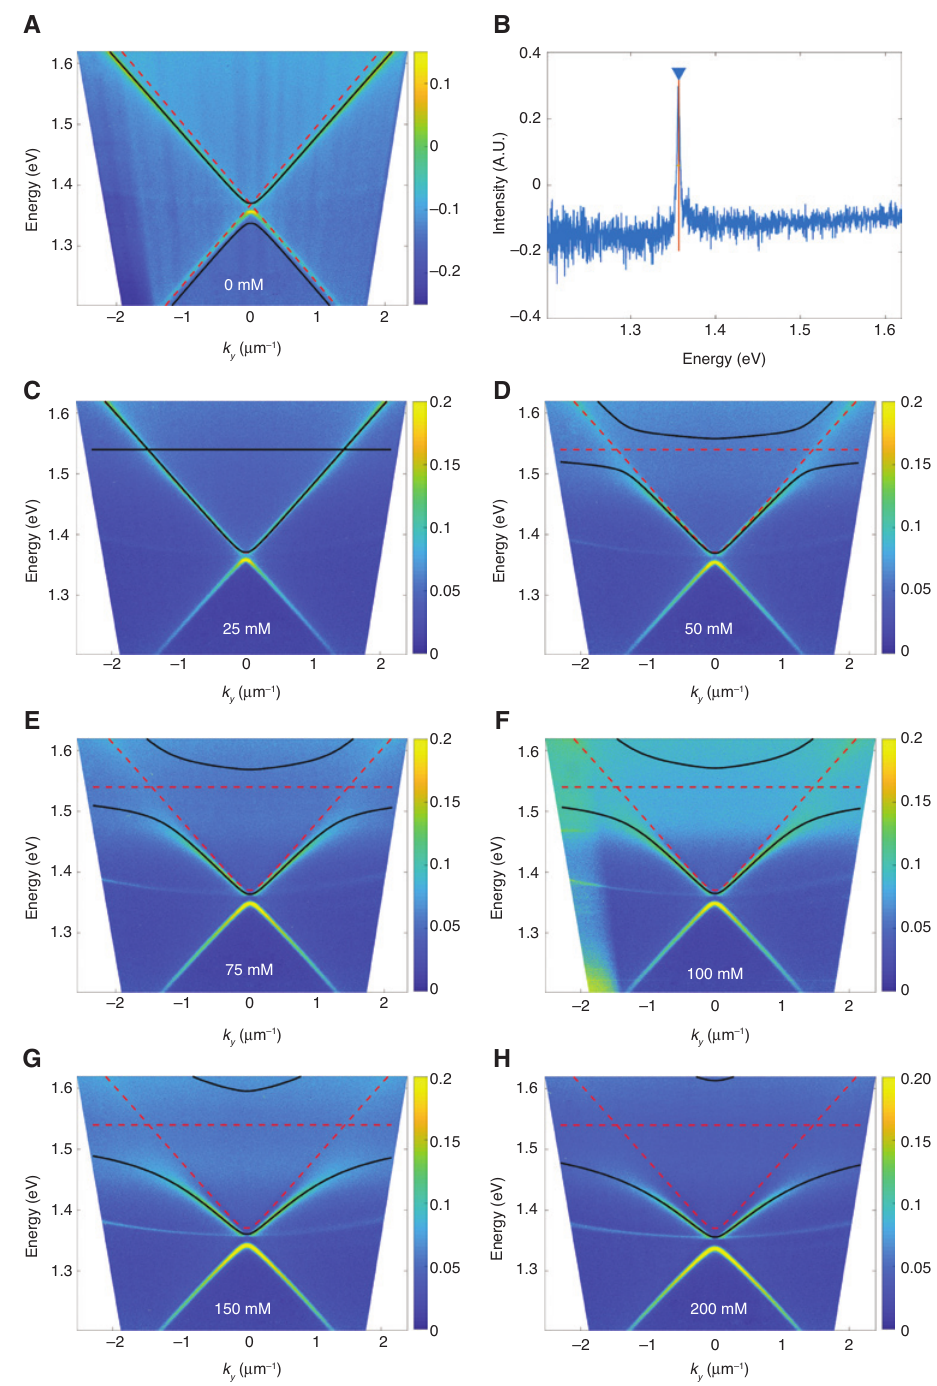
Figure 2: Measured extinction spectra in k -space. Dispersion measurements of a nanoarray of amorphous silicon nanoparticles with a periodicity of 600 nm in x- and y-directions, diameter of 100 nm, and dye concentrations of (A) 0 mm, (C) 25 mm, (D) 50 mm, (E) 75 mm, (F) 100 mm, (G) 150 mm, and (H) 200 mm. The film thickness is = 0. In (A), the red dashed lines depict the uncoupled 150 nm. Maximum extinction is given in yellow. (B) Shows a crosscut through (A) at k y diffracted orders of the lattice and the black solid lines the SLRs obtained by the coupled mode fitting of the extinction maxima. In (C–H), the horizontal red dashed line depicts the absorption line of the dye molecules and the diagonal red lines correspond to the fitted SLRs (upper branch) from (A). The solid black lines depict the coupled-modes fitting of the extinction maxima. It is clearly visible that the Rabi splitting increases with increasing dye molecule